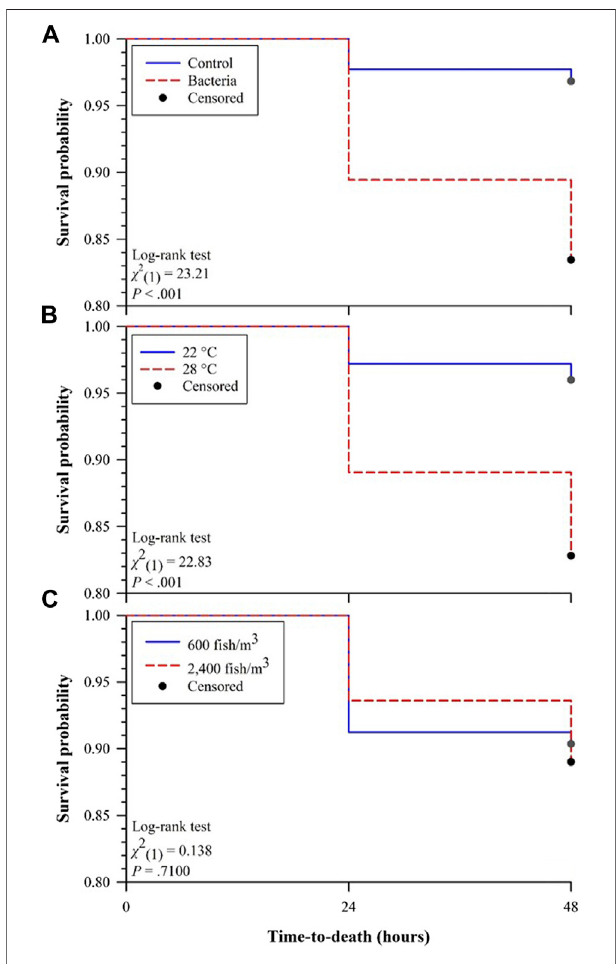
FIGURE 1 | Kaplan-Meier survival curves for effects of (A) challenge (control versus bacteria), (B) water temperature (22 ° C versus 28 ° C), and (C)